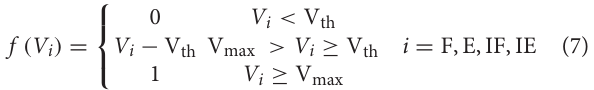
supraspinal region, s i ( i = F, E, IF, IE) is the feedback input